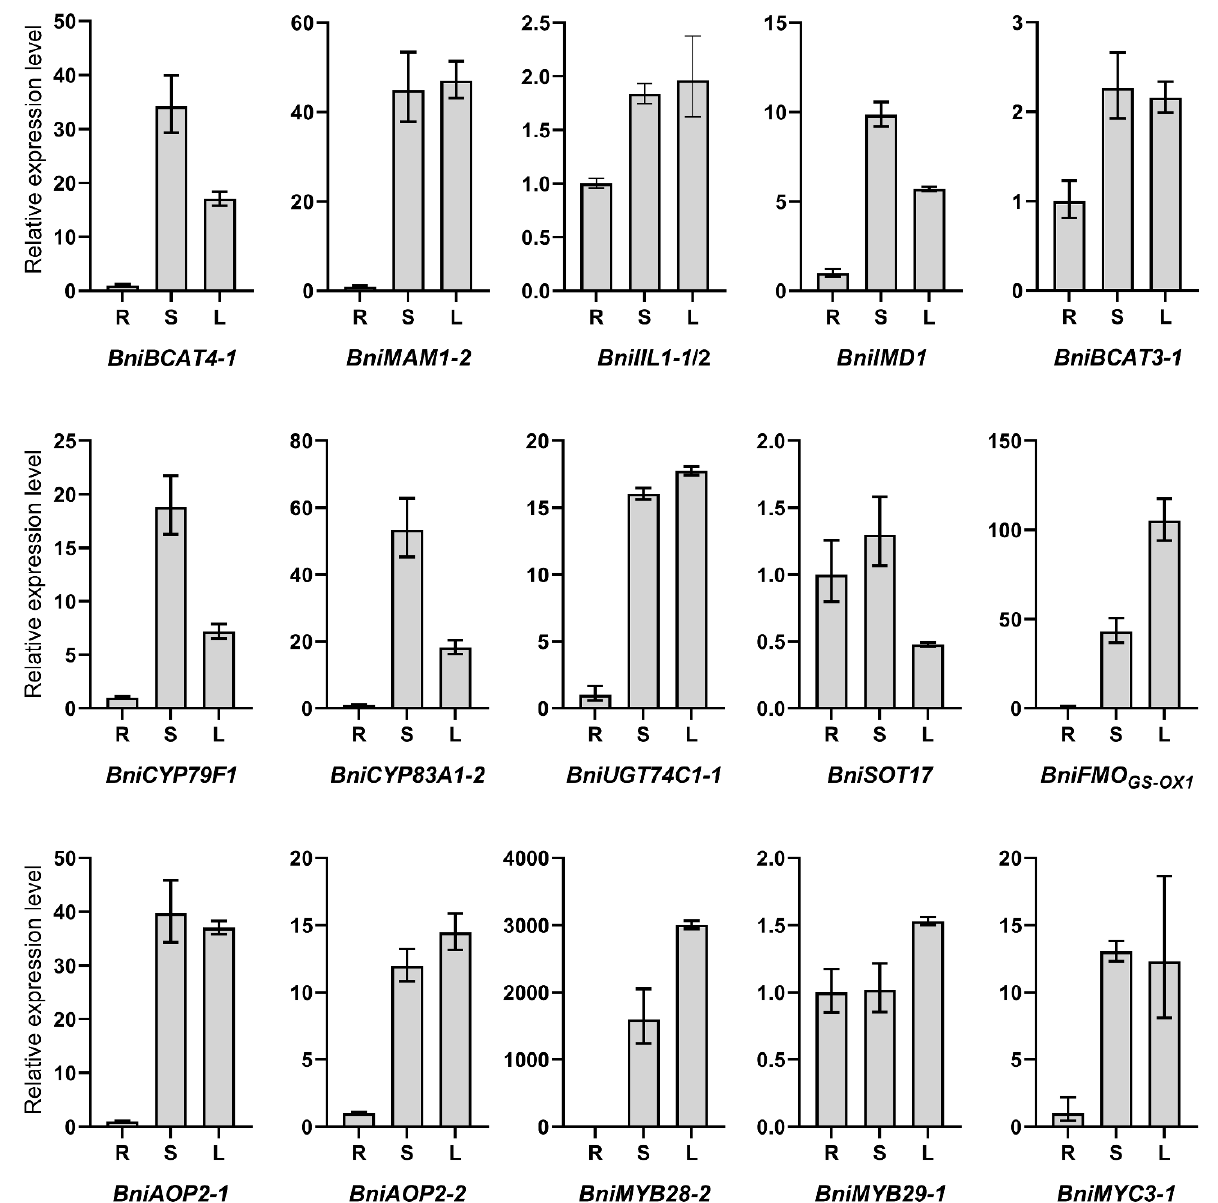
Figure 5. The qRT-PCR analysis of relative expression levels of 15 BniGSL genes in different organs of flowering plants. R, root; S, stem; L, leaf. TIPS was used as a reference gene, and the expression of BniGSL genes in root was set as 1. Error bars represent positive and negative deviations from three independent biological replicates.